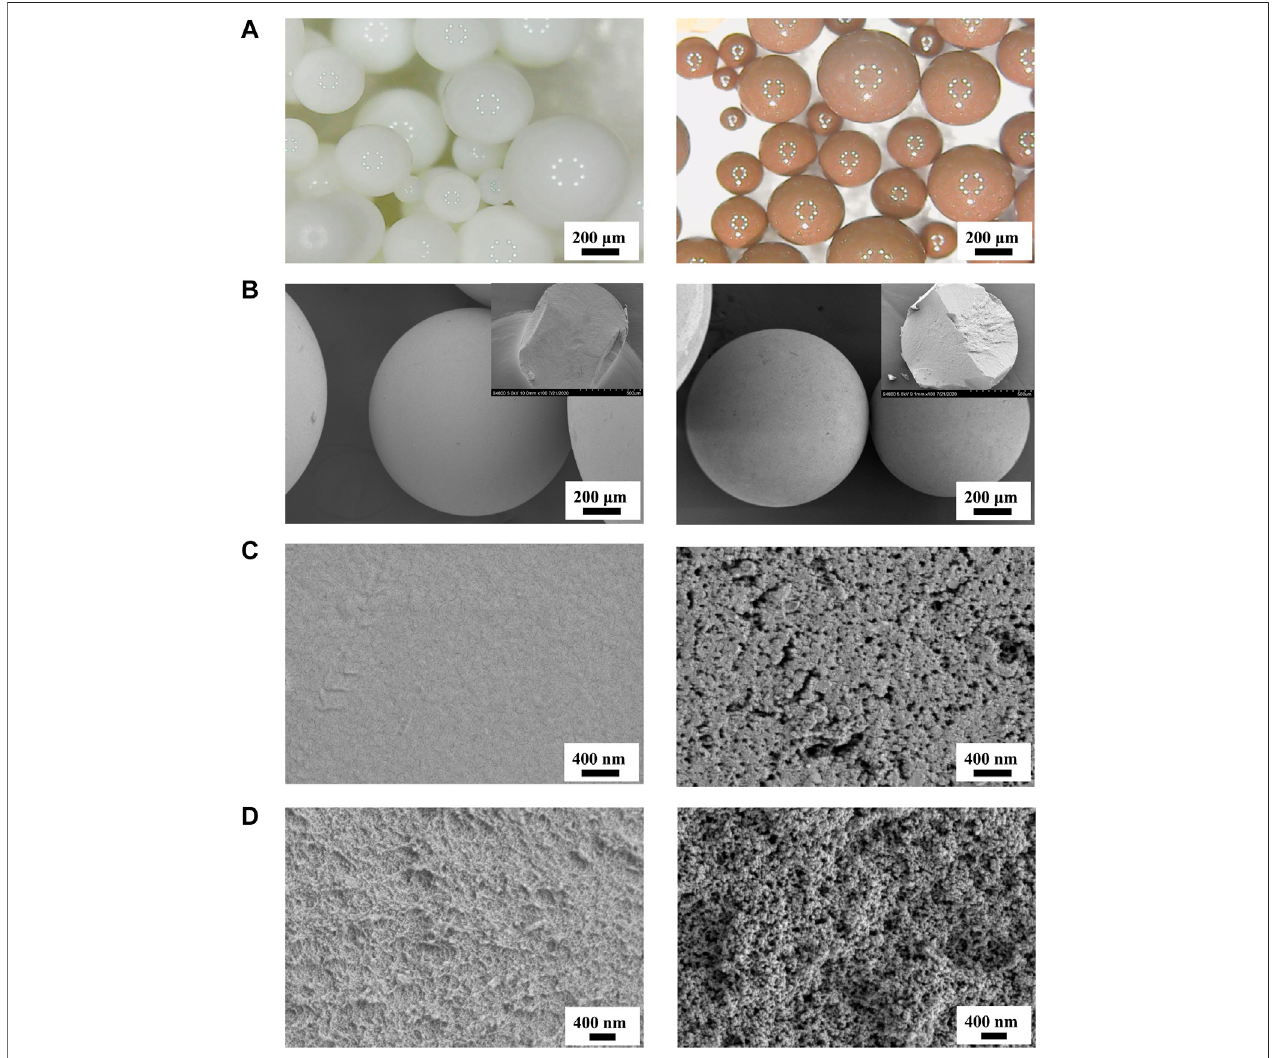
FIGURE 2 | Optical microscopy micrographs (A) and SEM images (B – D) of P(St-DVB-VP) and HCP(St-DVB-VP). (C) The surface zone; (D) the cross-sectionn zone. Insets of (B) are their SEM cross-section morphologies after mechanical compression. Left: P(St-DVB-VP), right: HCP(St-DVB-VP).